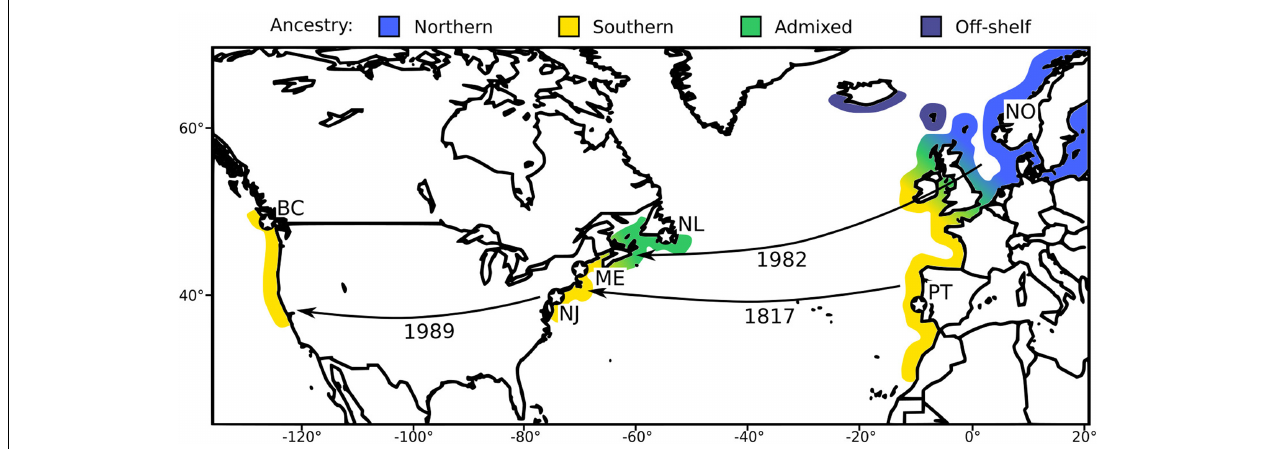
FIGURE 1 | A: Map of study locations and invasion history of C. maenas in North America. Colors correspond roughly to genetic background. “Off-shelf” indicates a genetically distinct lineage that has not become established outside the species’ native range (Roman and Palumbi, 2004). Arrows represent major introduction events, with date of first record given. Stars indicate study sites, with site codes from Table 1 . TABLE 1 | Sampling